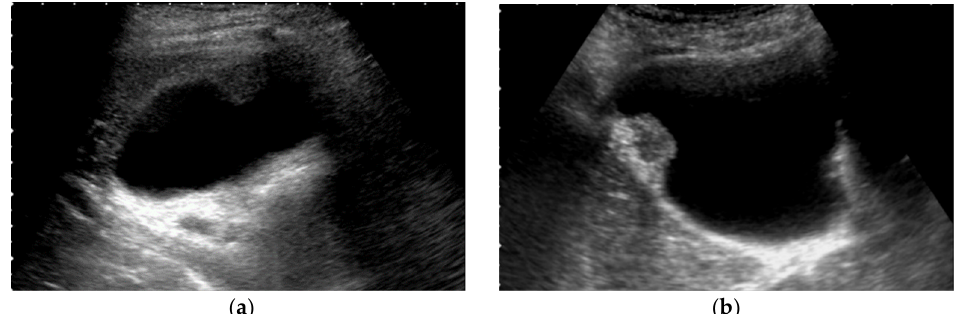
Figure 1 . Alteration of US images with postural changes. In the supine position, GBC in the fundus was obscured by reverberation artifacts ( a ), but a high-frequency probe can delineate the GBC in the left lateral decubitus position ( b ).